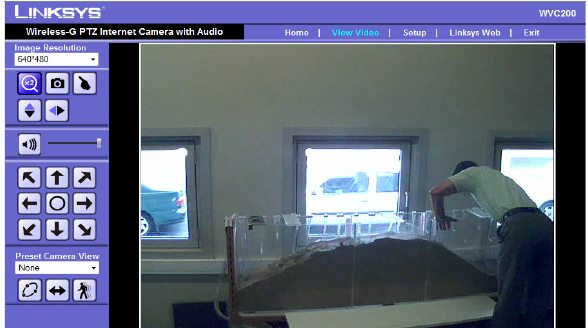
Figure 1. Lecturing through the intranet